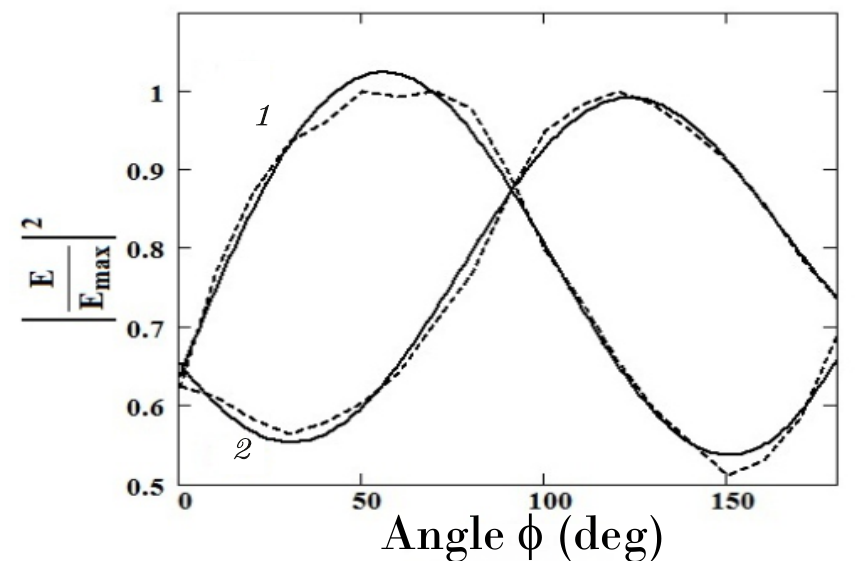
Figure 15. Square of the normalized amplitude of the signal received by the metal horn antenna as a function of the rotation angle φ at 1.55 GHz: measured signal (dashed line) and interpolation by a sinusoidal function of φ (solid